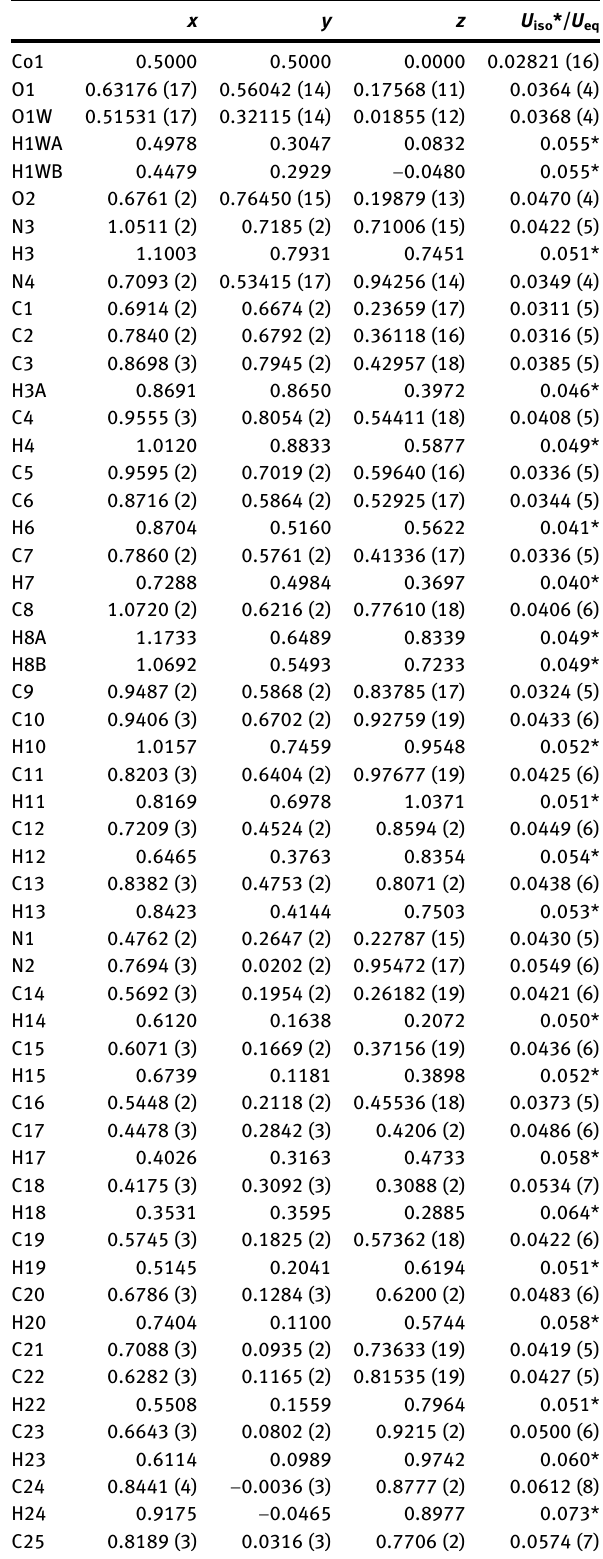
Table  : Fractional atomic coordinates and isotropic or equivalent isotropic displacement parameters (Å 